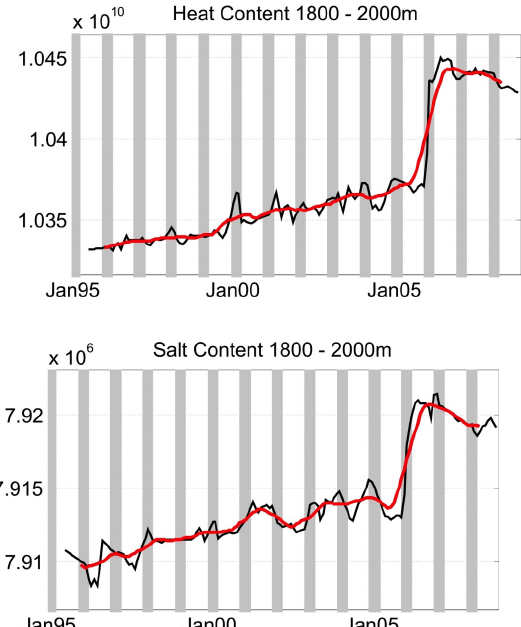
Fig. 15. (a) Temporal evolution of heat content (Jm − 2 ) of the Figure 3.2.2. (a) Temporal evolution of heat content (J m − 2 ) of the 1800-2000 m layer at the Dynamique des 1800–2000m layer at the Dynamique des Flux Atmosphériques Flux Atmosphériques en Méditerranée (DYFAMED) site in each 200 m layer from 0 to 2000 m (black line, en Méditerranée (DYFAMED) site in each 200m layer from observed; red line, moving average over 13 months). Shaded regions indicate the “ convection period” (December– March); (b) Same as Figure 3.2.2 (a) except for salt content (10 3 kg m − 2 ); (adapted from 0 to 2000m (black line, observed; red line, moving average Schroeder et al., 2010). over 13 months). Shaded regions indicate the “convection pe- riod” (December–March); (b) same as (a) except for salt content (10 3 kgm − 2 ) ; (adapted from Schroeder et al., 2010).